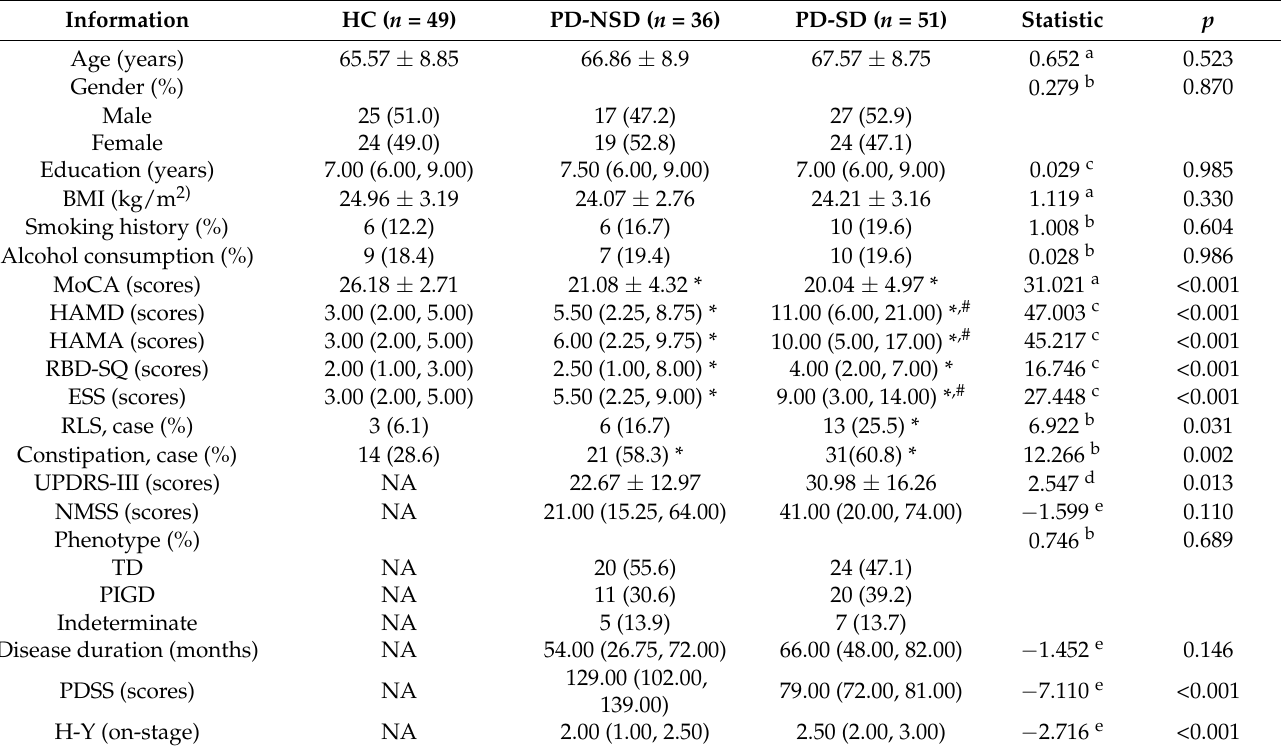
Table 1. Demographic characteristics and clinical data in each